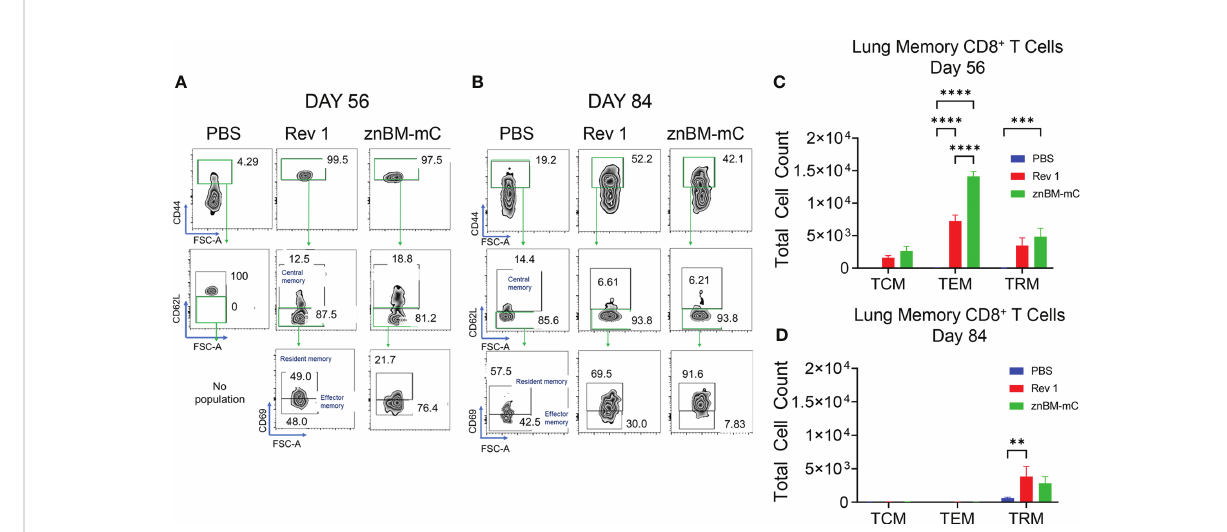
FIGURE 9 Mucosal vaccination with znBM-mC induces nonrecirculating lung memory CD8 + T cells comprised of TCMs, TEMs, and TRMs. Groups of BALB/c mice (10 – 14/group) were vaccinated and challenged as described in Figure 8. (A) Pre- (day 56) and (B) post-challenge (day 84) lung lymphocytes were isolated and restimulated with Ag overnight as described in Figure 7. FACS plots depict (A) day 56 and (B) day 84 noncirculating memory lung CD8 + T cells from mice vaccinated with sPBS, Rev 1, or znBM-mC. (C) Total numbers of pre-challenge and (D) post-challenge non-circulating lung CD8 + memory T-cell subsets are shown. Data are representative of two experiments: **p <0.005, ***p <0.0005, and ****p <0.0001 vs. PBS-dosed mice.